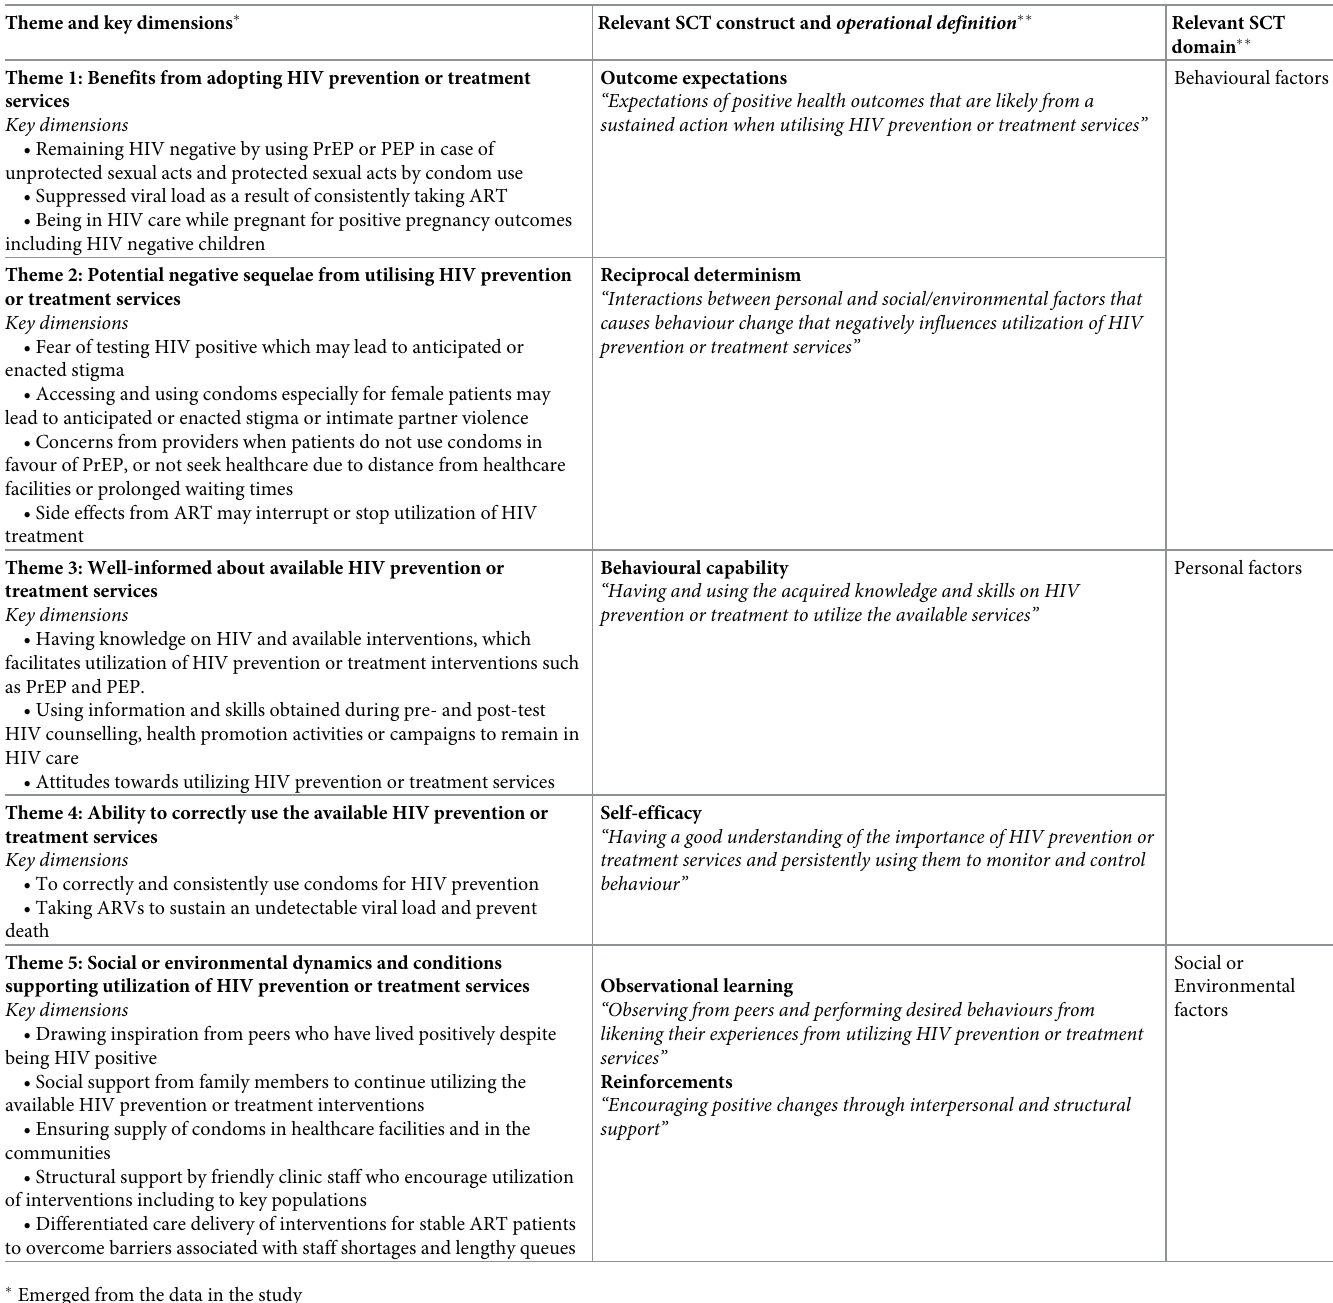
Table 2. Themes and key dimensions from in-depth interviews and their relevant SCT constructs and domains. Theme and key dimensions